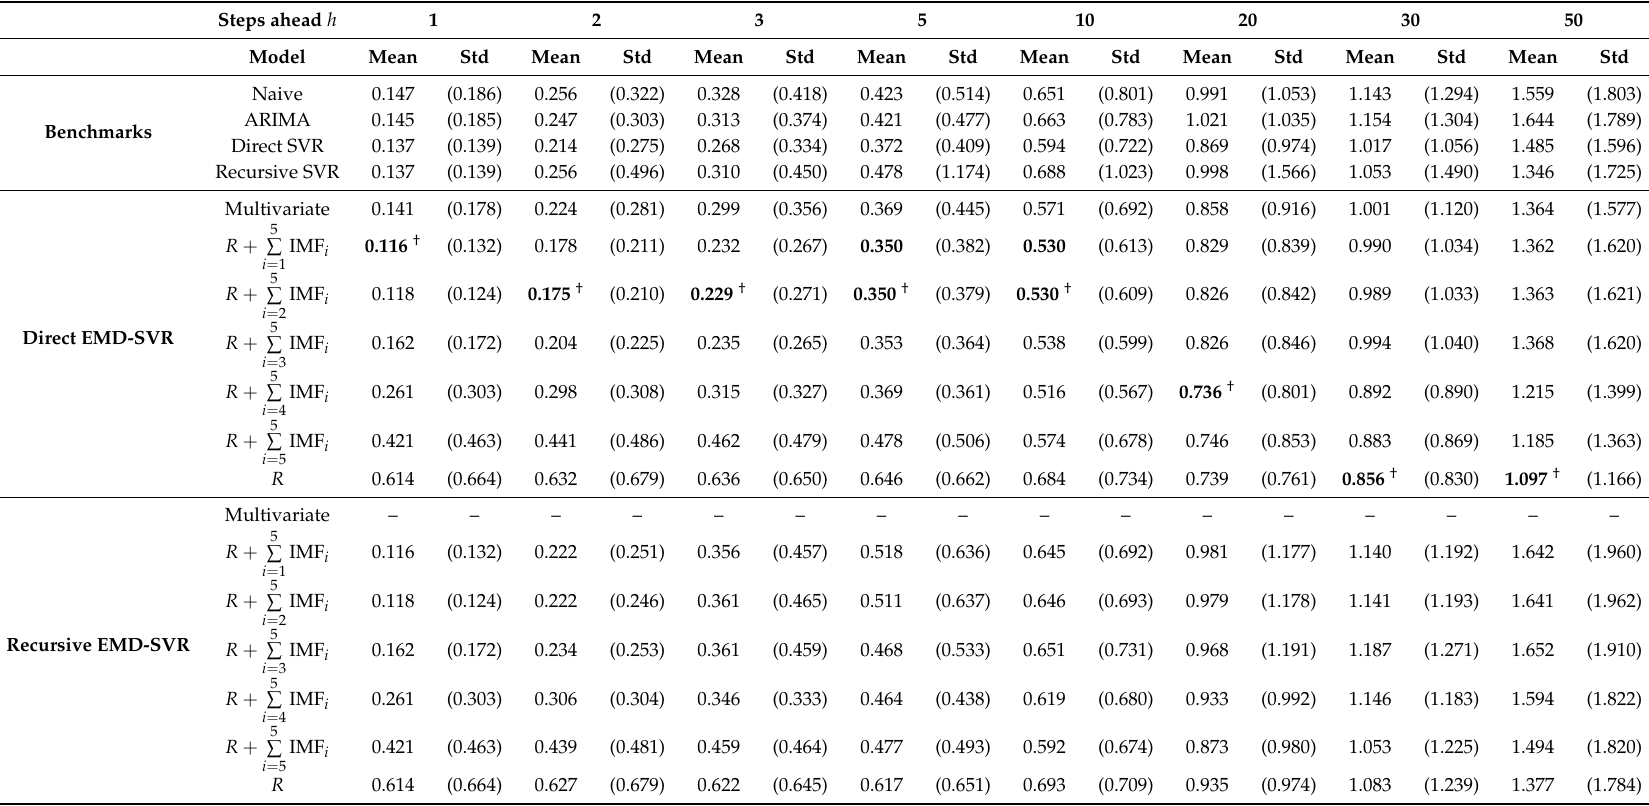
Table 2. Mean and standard deviation (std) of mean absolute error (MAE) computed for all the 128 days for all the forecasting models: Naive, ARIMA ( p , d , q ) , direct and recursive SVR on the original data, direct and recursive univariate and multivariate EMD-SVR with input vector m = p + d lagged values, the same input vector as the ARIMA ( p , d , q ) model. Small MAE indicate better forecasting. The smallest MAE of each forecast horizon is set in boldface. The values marked with a dagger (†) indicate the smallest MAE of each horizon across all the models with different input vector m (see Tables A1 and